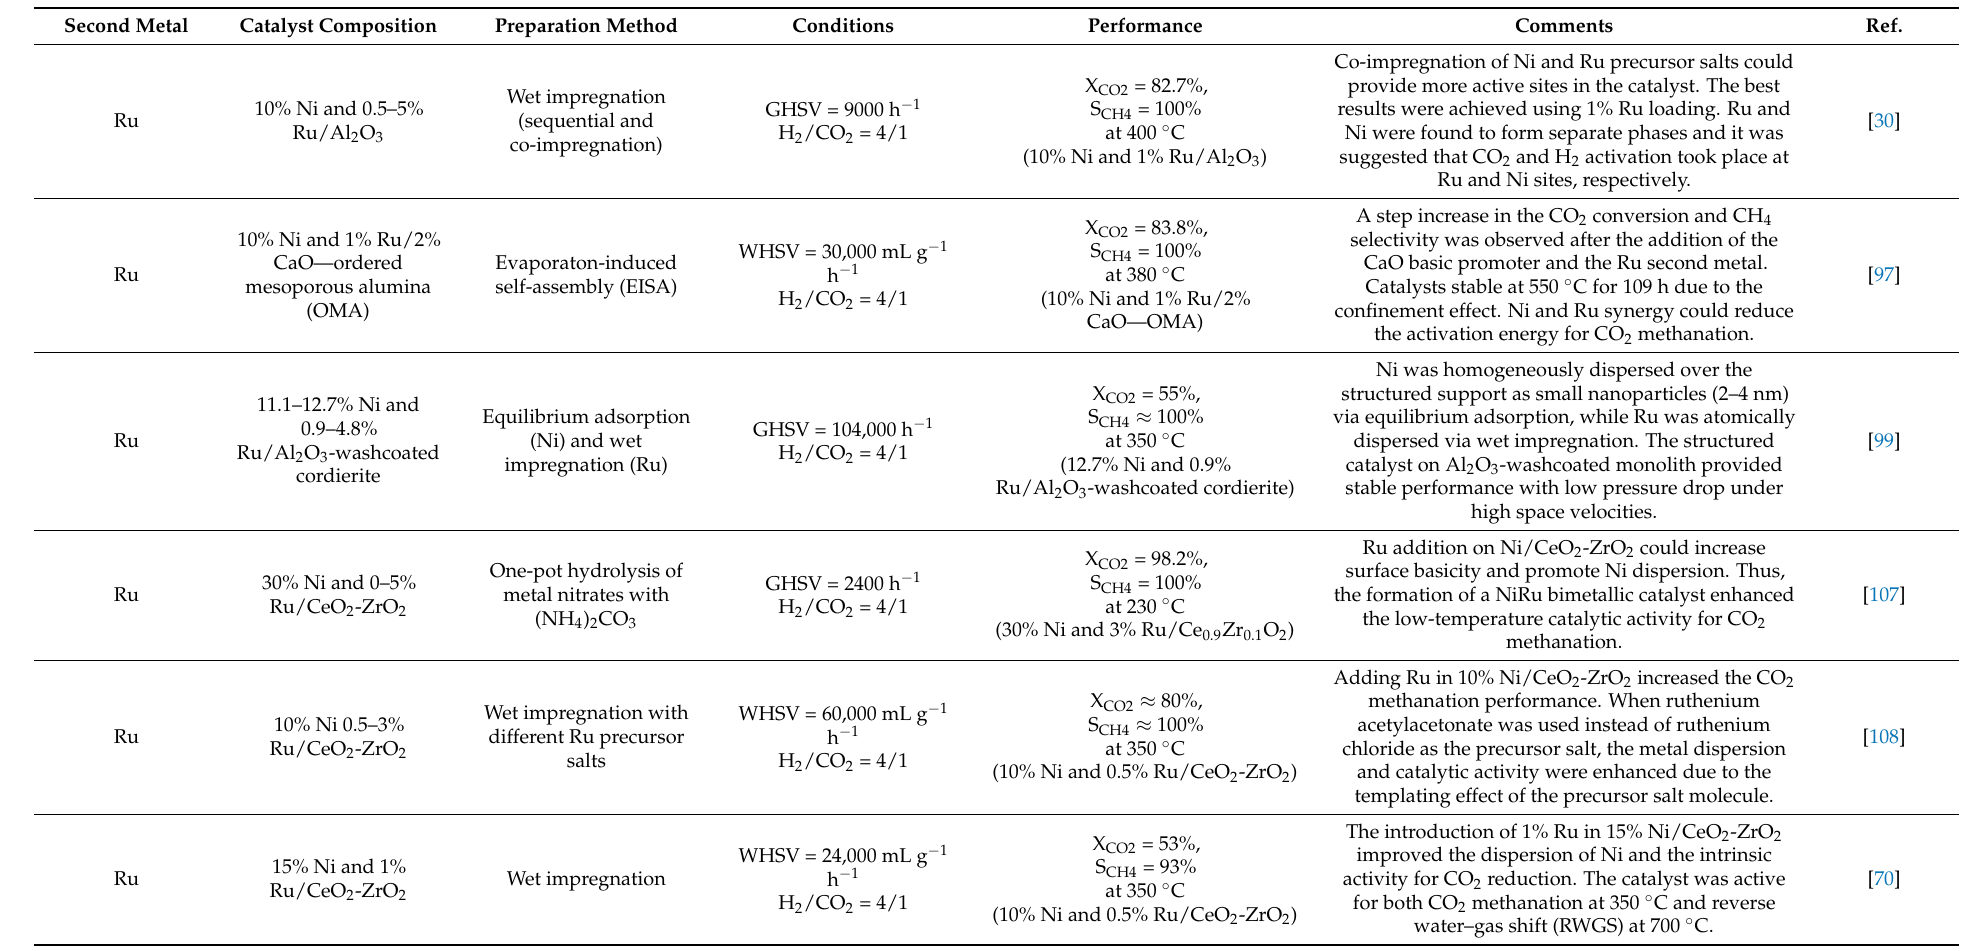
Table 2. Summary of some typical bimetallic Ni-based catalysts promoted with noble metals (Ru, Rh, Pt, Pd and Re) for the methanation of CO 2